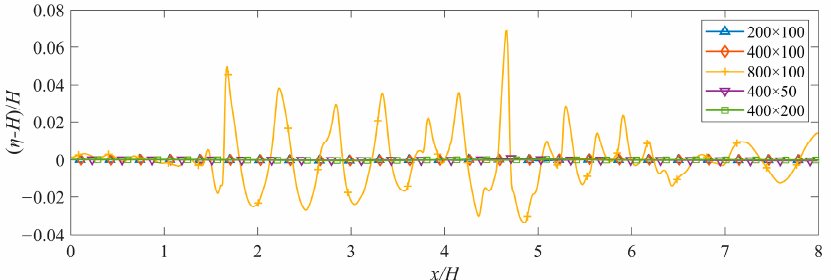
Figure 13. The elevations η of surface at t = 18.0 s for the simulations of lock-exchange problem with the superbee